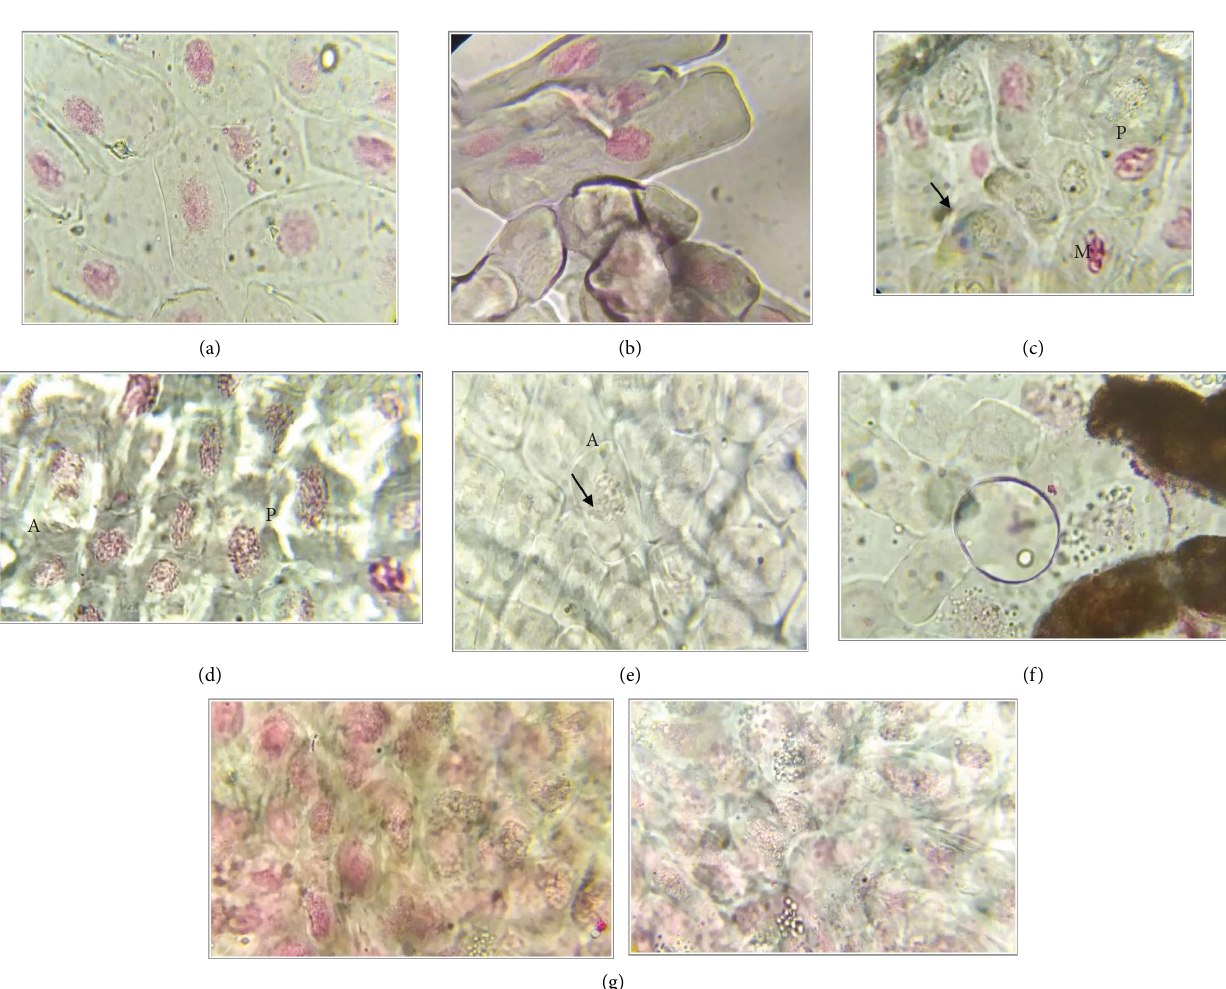
Figure 11: Common view of cells under an optical microscope with a magnifcation × 1000. (a) Control: normal prophase cells with dyed nuclei contained of visible and tangled chromosomes. (b) AgNP B-GPE 1%: osmotically damaged prophase cells with visible nuclei. (c) AgNP B-GPE 5%: irregular prophase ( P ) and irregular metaphase ( M ) cells with micronucleus (arrows). (d) AgNP B-GPE 10%: prophase ( P ) and irregular anaphase ( A ) cells with apoptosis features under osmotic shock. (e) AgNP B-GPE 1%: irregular anaphase ( A ) cell with not dyed nuclei and a micronucleus (arrow). (f) AgNP B-GPE 5%: irregular prophase cells. Large dark spots on the right side is the deposited of AgNP. (g) AgNP B-GPE 10%: prophase damaged cells under osmotic shock. Prophase cells with apoptosis features under osmotic